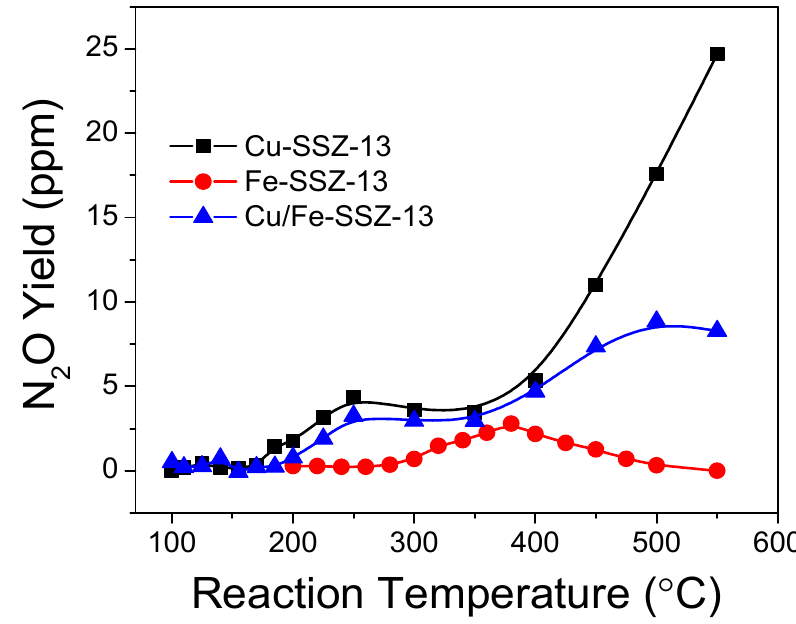
Figure 17. N 2 O formation as a function of temperature during standard SCR for the HTA Cu / SSZ-13, Fe / SSZ-13 and mixed (1 / 1) samples. Reactant feed contains 350 ppm NO, 350 ppm NH 3 , 14% O 2 , 2.5% H 2 O balanced with N 2 at a GHSV of 200,000 h − 1 . Reprinted with permission from [33]. Copyright © 2015 Elsevier B.V.